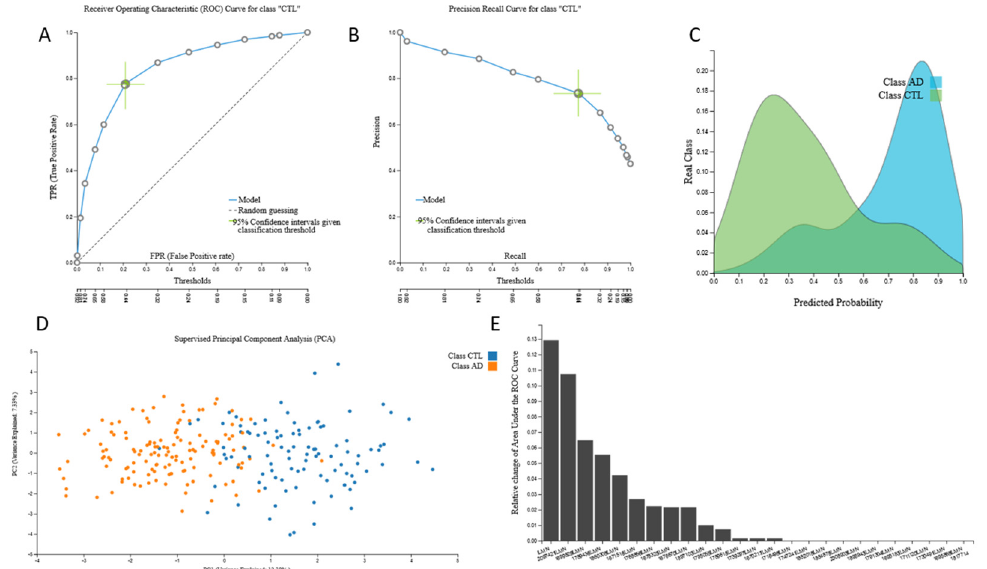
Figure 3. The 38,327-feature mRNA-transcriptomic original dataset signature performance, selected predictors and model inspection: ( A ). Receiver Operating Characteristic (ROC) Curve for AD class, ( B ). Precision-recall plot, ( C ). Probabilities density plot, ( D ). Supervised Principal Component Analysis plot depicting discrimination between AD patients and age–sex matched cognitively healthy individuals, ( E ). Cumulative feature importance plot of the 25 mRNA predictors of the reference signature.